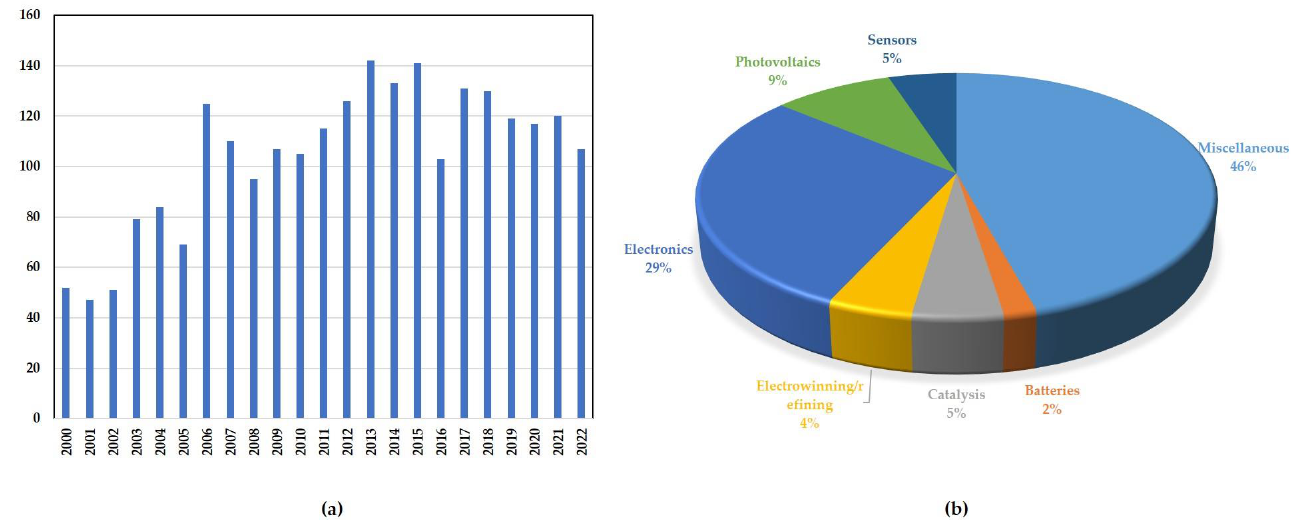
Figure 2. ( a ) Breakdown of the number of papers published on copper electrodeposition from 2000 till December 2022. Data taken from a search of the Scopus database with different key words: electrodeposition; copper; carbon capture, electrochemical reduction of carbon dioxide, carbon capture utilisation and storage. (b) Applications of electrodeposited copper that were reported from 2000 till December 2022. Data taken from a search of the Scopus database.